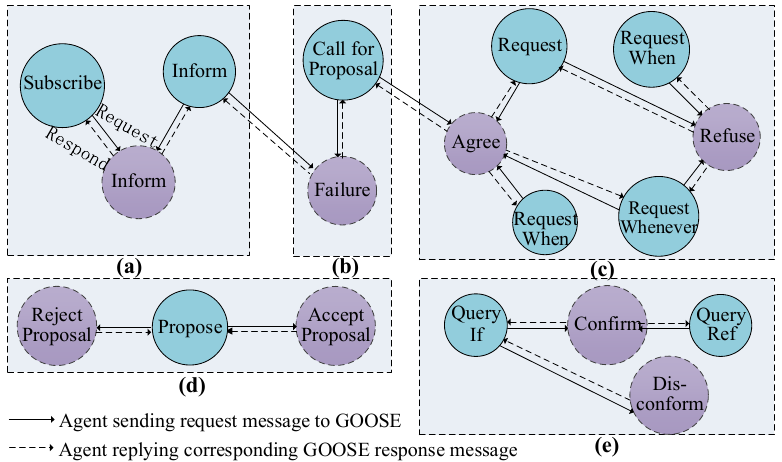
Figure 6. Bidirectional interaction mechanism of GOOSE communication: ( a ) replies of subscribe and inform messages; ( b ) reply of proposal message; ( c ) replies of request messages; ( d ) replies of propose message; and ( e ) replies of query